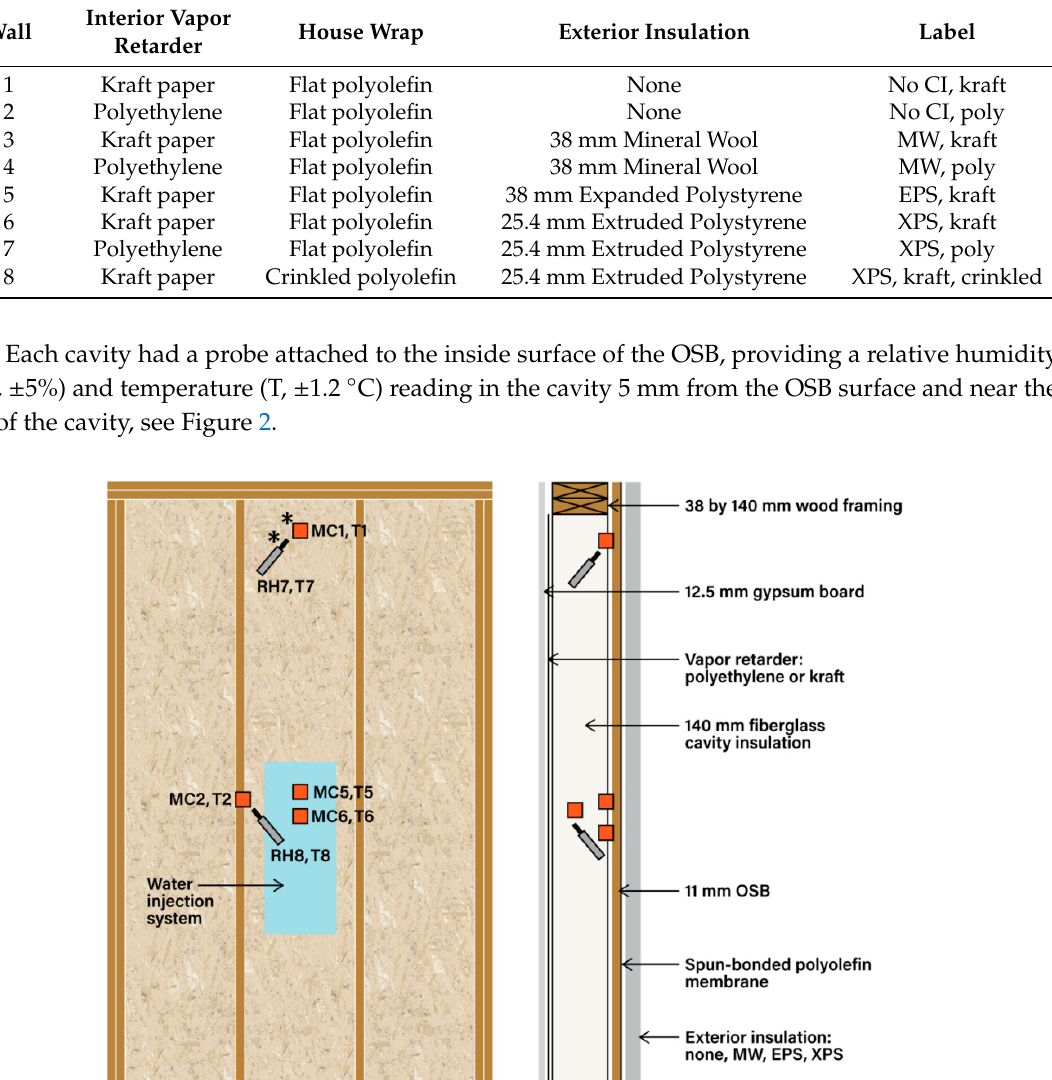
Table 1. Wall configuration summary.